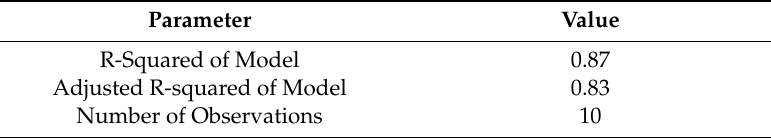
Table 5. Statistics on the goodness-of-fit of the MLR model.